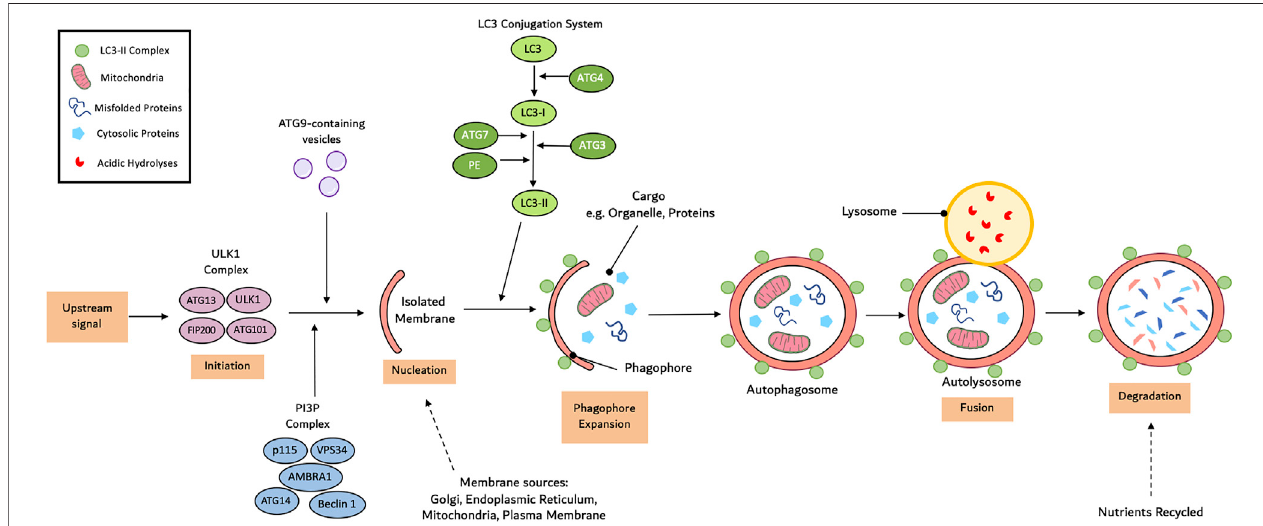
FIGURE 1 | Mechanism of autophagy. Autophagy initiates with the formation of an isolated membrane/phagophore. Coordinated action of core autophagy machinery proteins results in the expansion of though phagophore into an autophagophore, which surrounds the cargo. Next, fusion with the lysosome result in the formation of the autophagolyososme. Lastly sequestered material is broken down inside the autophagolyosome and recycled.